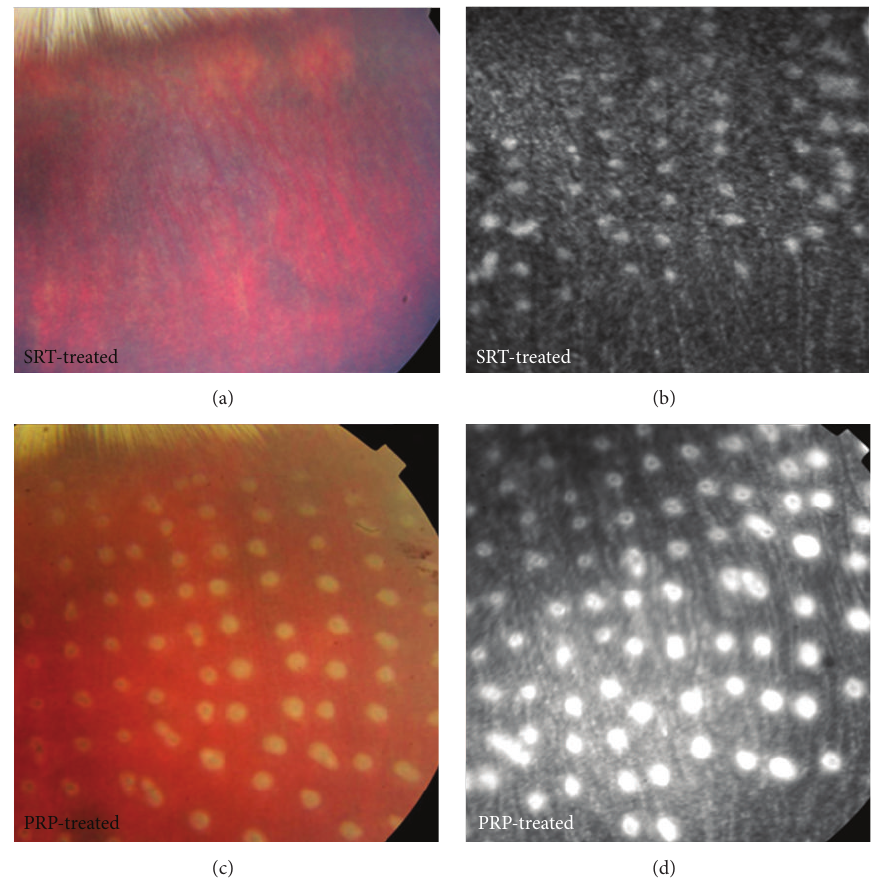
Figure 2: (a) A fundus image obtained 1h after selective retina therapy (SRT) revealed no visible SRT spots. (b) Fluorescein angiography (FA) performed 1hr after the irradiation showed hyperfluorescence on SRT spots. (c) A fundus photograph taken 1hr after conventional PRP showed whitish spots. (d) FA performed 1hr after PRP showed larger hyperfluorescence than that of SRT, although the same spot size (200 𝜇 m) was